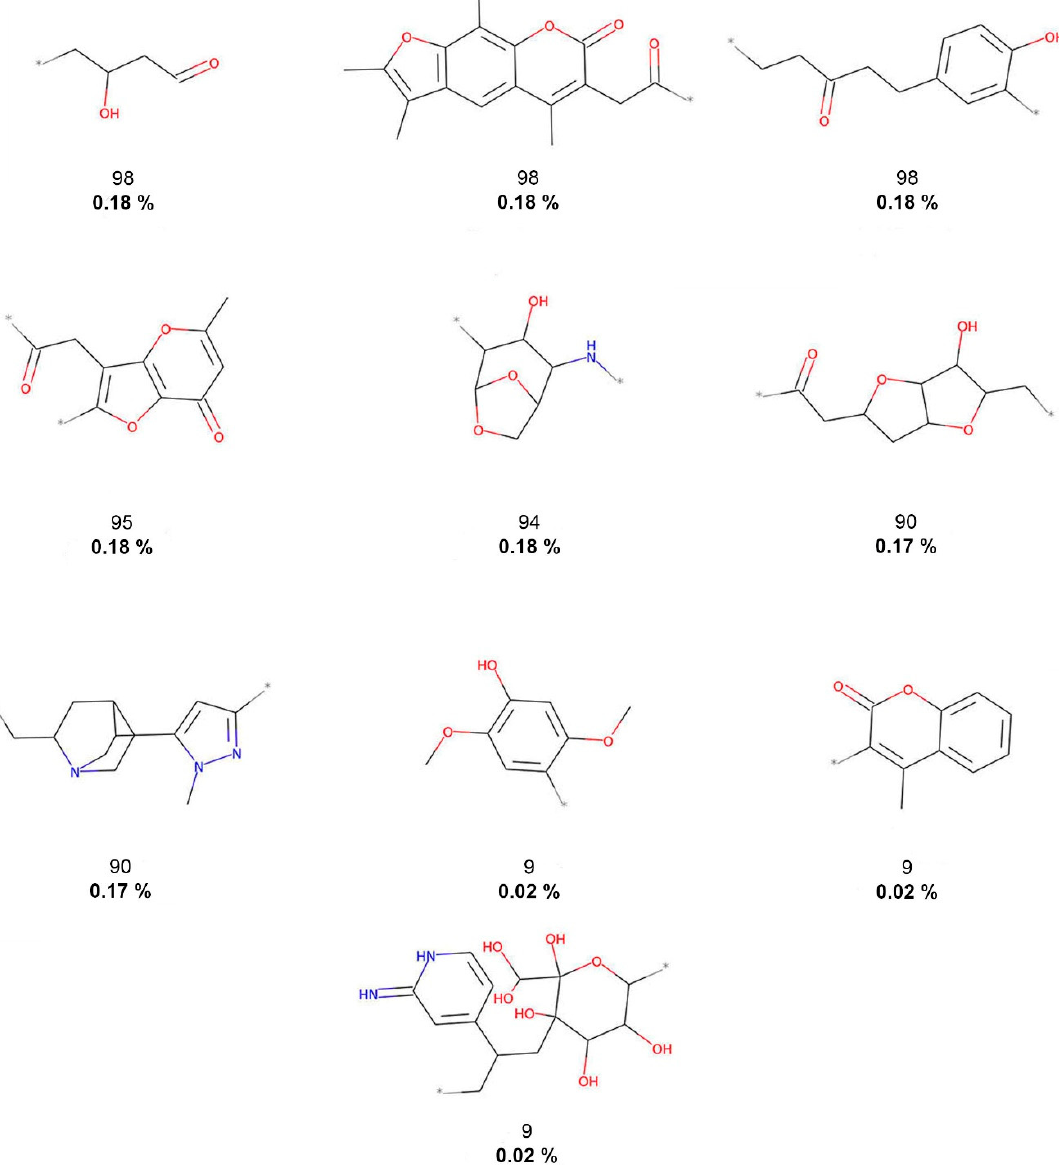
Figure 2. The 10 most frequent and unique COCONUT fragments. Frequency (regular font) and proportion (bold font) are listed below the chemical structures.